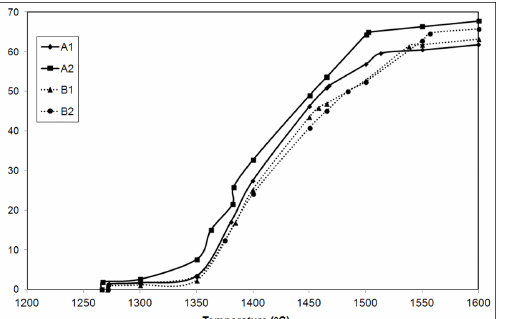
Figure IV. Free opening rate as a function of the steel %C and process temperature. A1